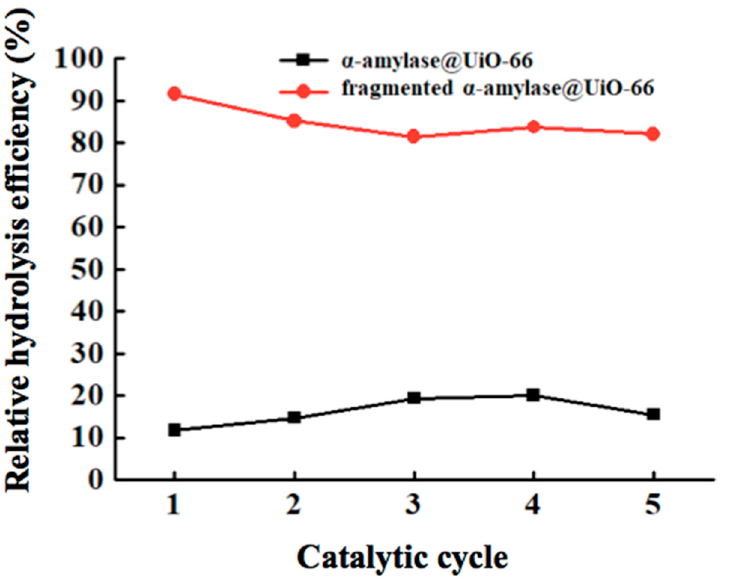
Figure 1. Comparison of the starch hydrolysis efficiency of native and fragmented α -amylase@UiO-66. Table 1. Window/channel size, BET surface area, and catalytic efficiency (%) of fragmented α - amylase on metal-organic frameworks (MOFs) supports.